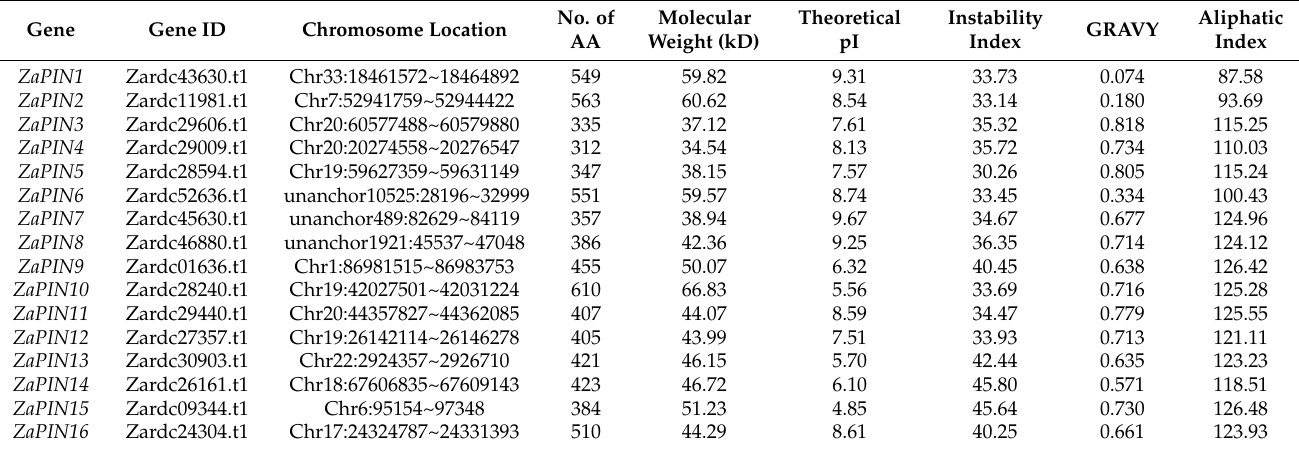
Table 2. Characteristics of PINs in Z. armatum .